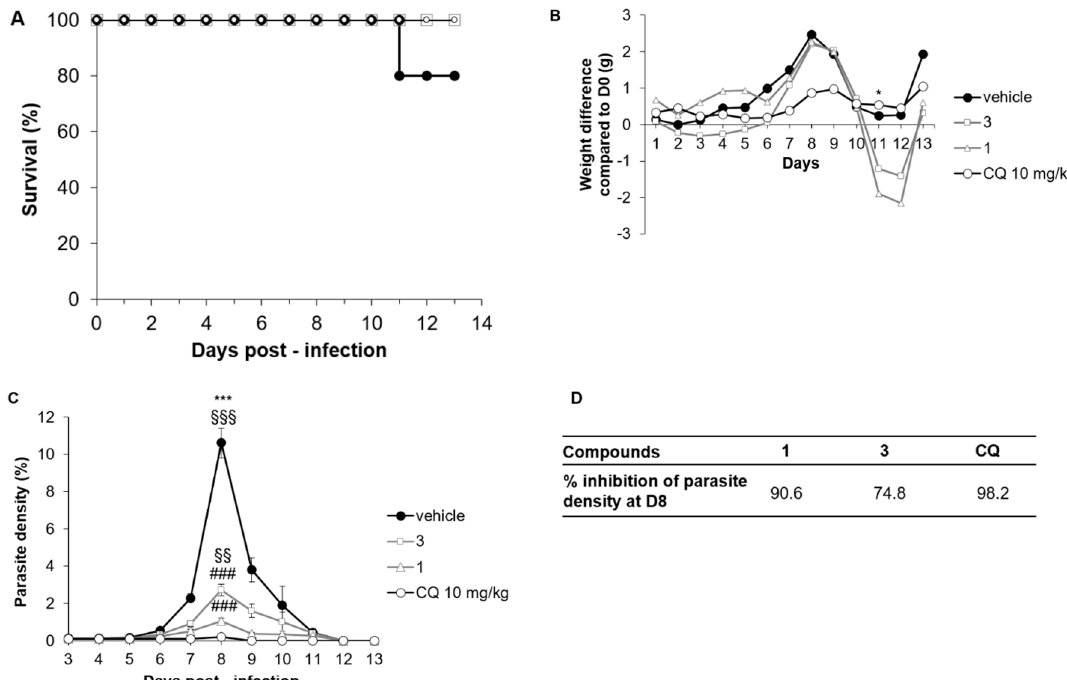
Figure 4. Effect of treatment with Compounds 1 and 3 on survival, parasitemia and weight of Plasmodium chabaudi chabaudi -infected mice, compared to chloroquine and vehicle treated animals. Mice ( n = 5 per group) were infected with 10 6 Pcc /mice at D0 before being daily treated intraperitoneally with 1 and 3 (both at 50 mg/kg), chloroquine (CQ, 10 mg/kg), or their vehicle (50% DMSO) during 4 days (D0 to D3). Mice were clinically monitored during 13 days. ( A ) Survival, ( B ) weight difference compared to D0, ( C ) parasite density (%), and ( D ) % inhibition of parasite density according to treatment. Groups were compared together by Kruskal–Wallis test (* p < 0.05, *** p = 0.0005), or to CQ by Bonferonni–Dunnett comparison (§§§ p < 0.0005, §§ p < 0.005), or to DMSO (### p < 0.0005).